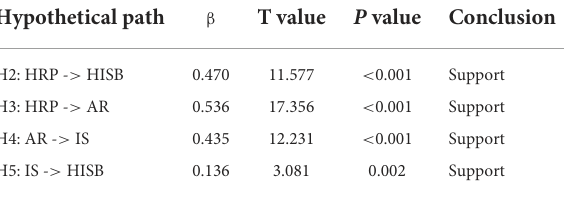
TABLE 7 The results of hypothesis testing.